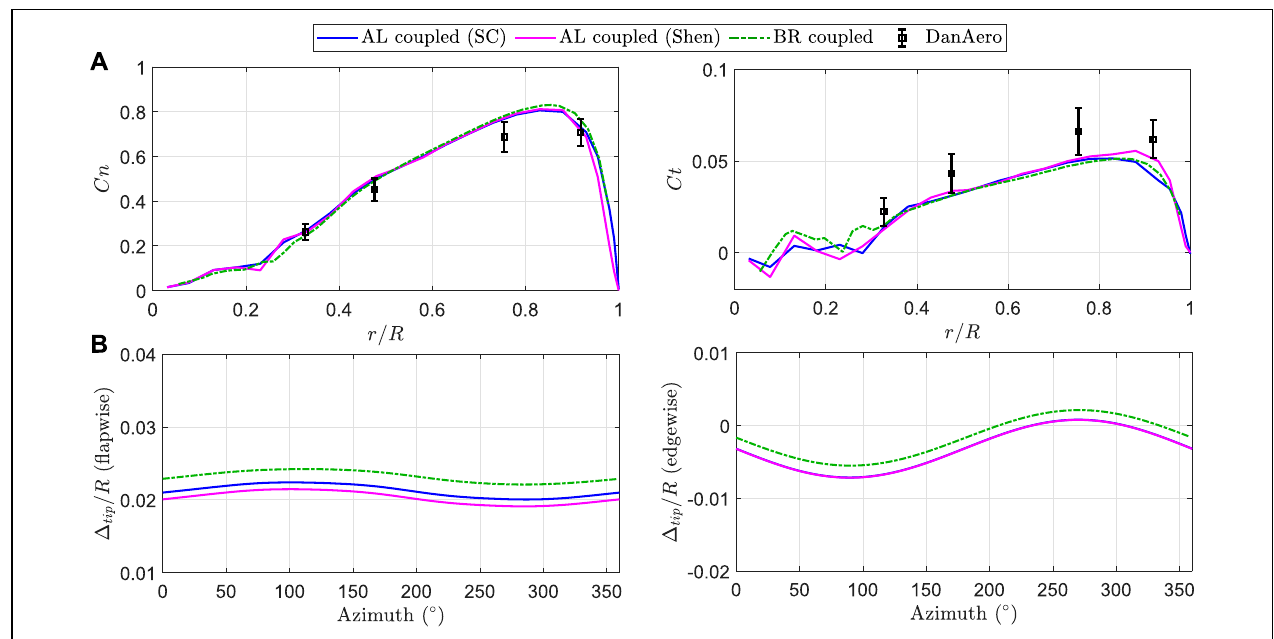
FIGURE 5 | Case 1: axisymmetric. (A) Normalised normal and tangential blade loads distribution at 0 ° azimuth; (B) Normalised flapwise and edgewise tip